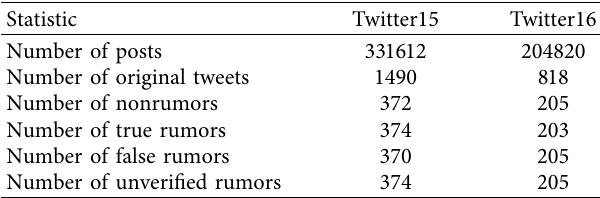
Table 2: Statistics of the datasets.